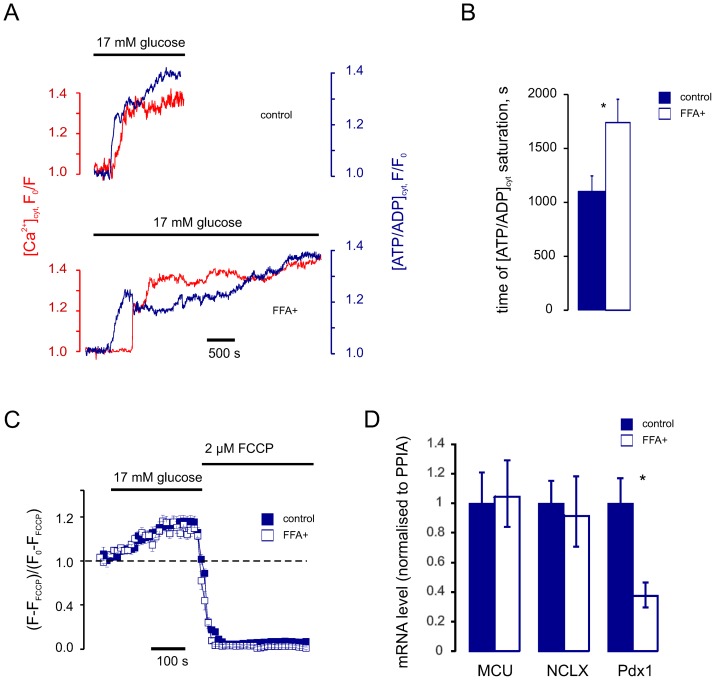
Chronic glucolipotoxicity slows down the second phase of glucose-induced ATP elevation. A
: Glucose-induced changes in [ATP/ADP]cyt and [Ca2+]cyt were monitored in control (above) and FFA+ (below) cells using Perceval and Fura-Red. B: Mean time of saturation of the second phase of [ATP/ADP]cyt increase in control (blue columns, n = 16) and FFA+ (white columns, n = 13) cells. C: Changes in ΔΨm measured as mitochondrial TMRE fluorescence, in response to the increase of glucose from 3 to 17 mM, in control and FFA+ β-cells. The data are expressed as (F-FFCCP)/(F0-FFCCP), where F0 and FFCCP represent TMRE fluorescence intensity in 3 mM glucose and 2 µM FCCP, respectively. D: Normalised MCU (Ccdc109a), NCLX (Slc24a6) and Pdx1 (Pdx1) mRNA expression levels for control and FFA+ cells. *Differences are significant (p<0.05).